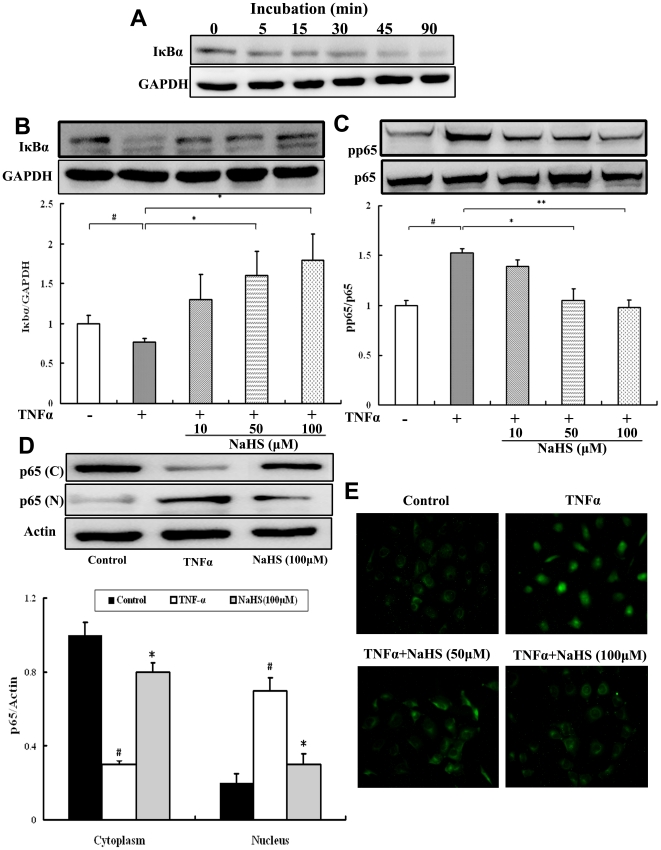
NaHS inhibited TNF-α-induced IκBα degradation and NF-κB activation.(A) IκBα degradation was analyzed by Western blot in HUVEC stimulated with TNF-α (10 ng/ml) for indicated periods. (B) HUVEC were incubated with indicated concentrations of NaHS for 30 min, then stimulated with TNF-α (10 ng/ml) for another 15 min. IκBα degradation was analyzed by Western blot. (C) HUVEC were incubated with indicated concentrations of NaHS for 30 min, then stimulated with TNF-α (10 ng/ml) for another 15 min. Phosphorylation levels of NF-κB p65 was analyzed by Western blot. (D) HUVEC were incubated with NaHS (100 µM) for 30 min, then stimulated with TNF-α (10 ng/ml) for another 1 h. Cytoplasmic and nuclear levels of NF-κB p65 were analyzed by Western blot. #
P<0.05 compared with unstimulated cells, *P<0.05, **P<0.01 compared with TNF-α-stimulated cells. Data are the mean ± S.E.M of results from at least three independent experiments, each performed in duplicate. (E) HUVEC were incubated with NaHS (50, 100 µM) for 30 min, then stimulated with TNF-α (10 ng/ml) for another 1 h. NF-κB p65 translocation was detected by fluorescent microscope.